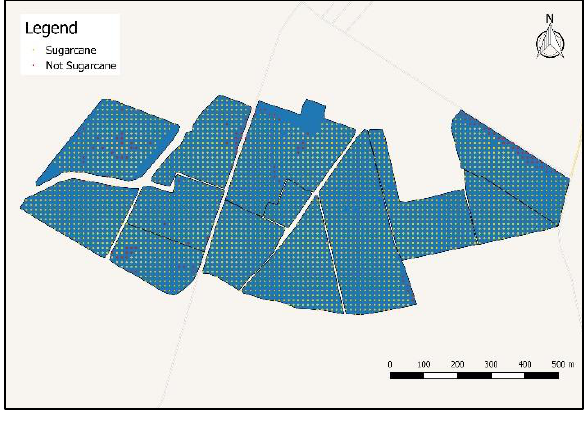
Figure 9. Selected training